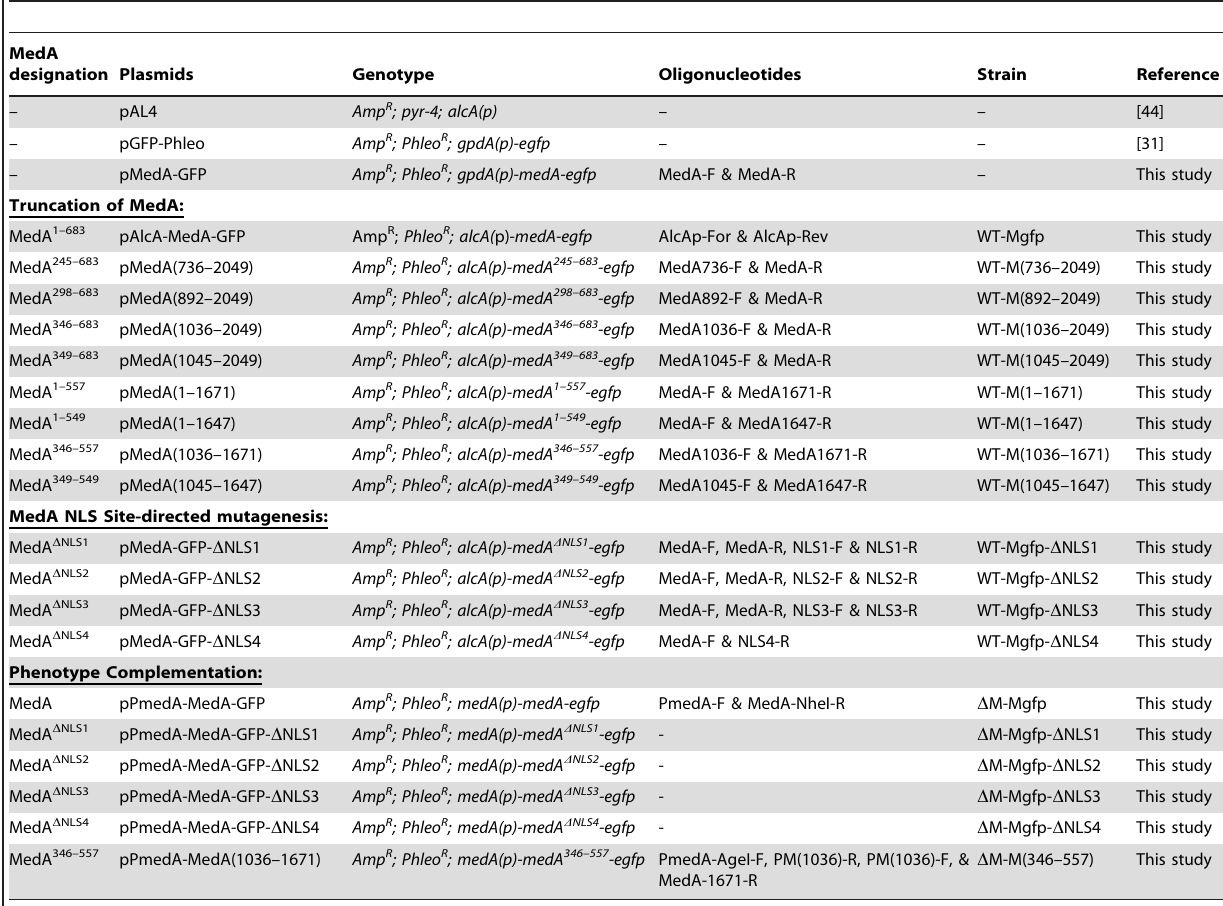
Table 2. Plasmids used in this study, combination of oligonucleotides, and the corresponding expression strains of A.